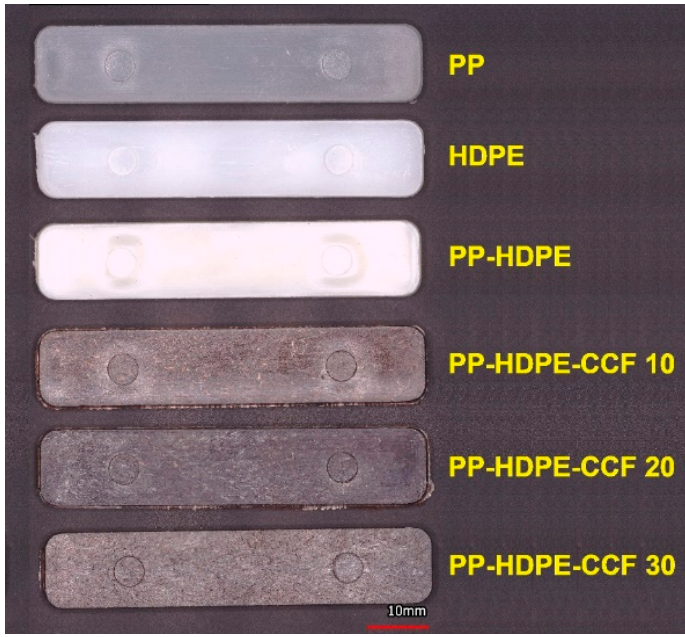
Figure 2. Injected specimens of neat PP, HDPE, PP-HDPE blend, and their biocomposites.